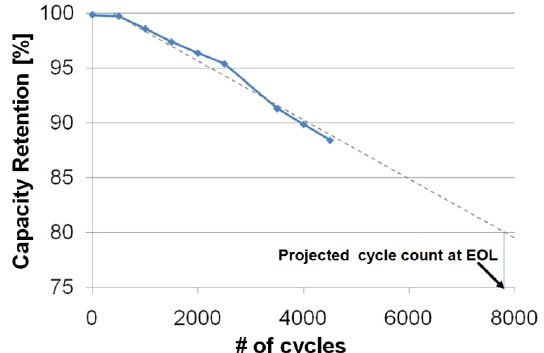
Figure 7. An actual experiment result for the CD cycles with SK Innovation’s commercialized 15 Ah PHEV cell. The dashed line indicates extrapolated cycle count at the end-of-life of the battery.